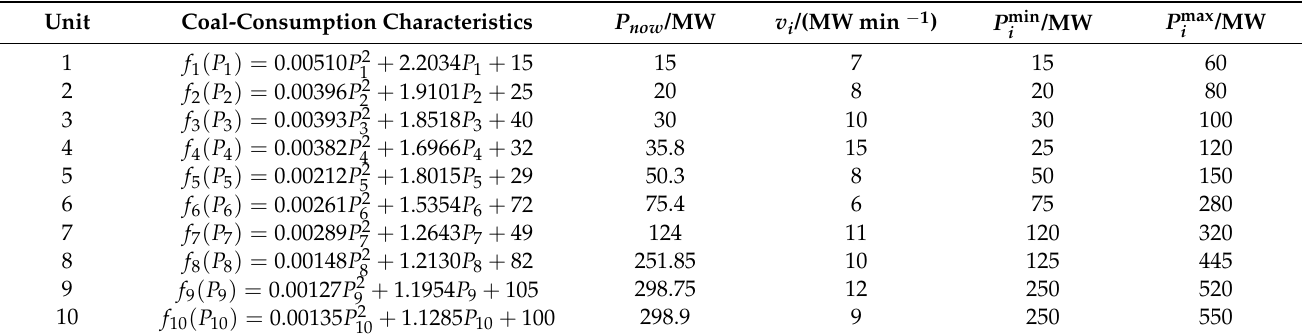
Table 8. Characteristics of 10 dispatched units with various power scales based on economy and speediness.